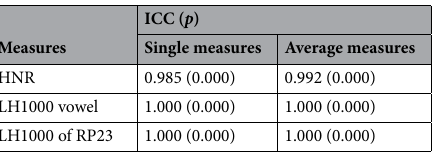
Table 1. Inter-rater reliability of acoustic analyses. RP23 = The 2nd and 3rd sentences of the Rainbow Passage.